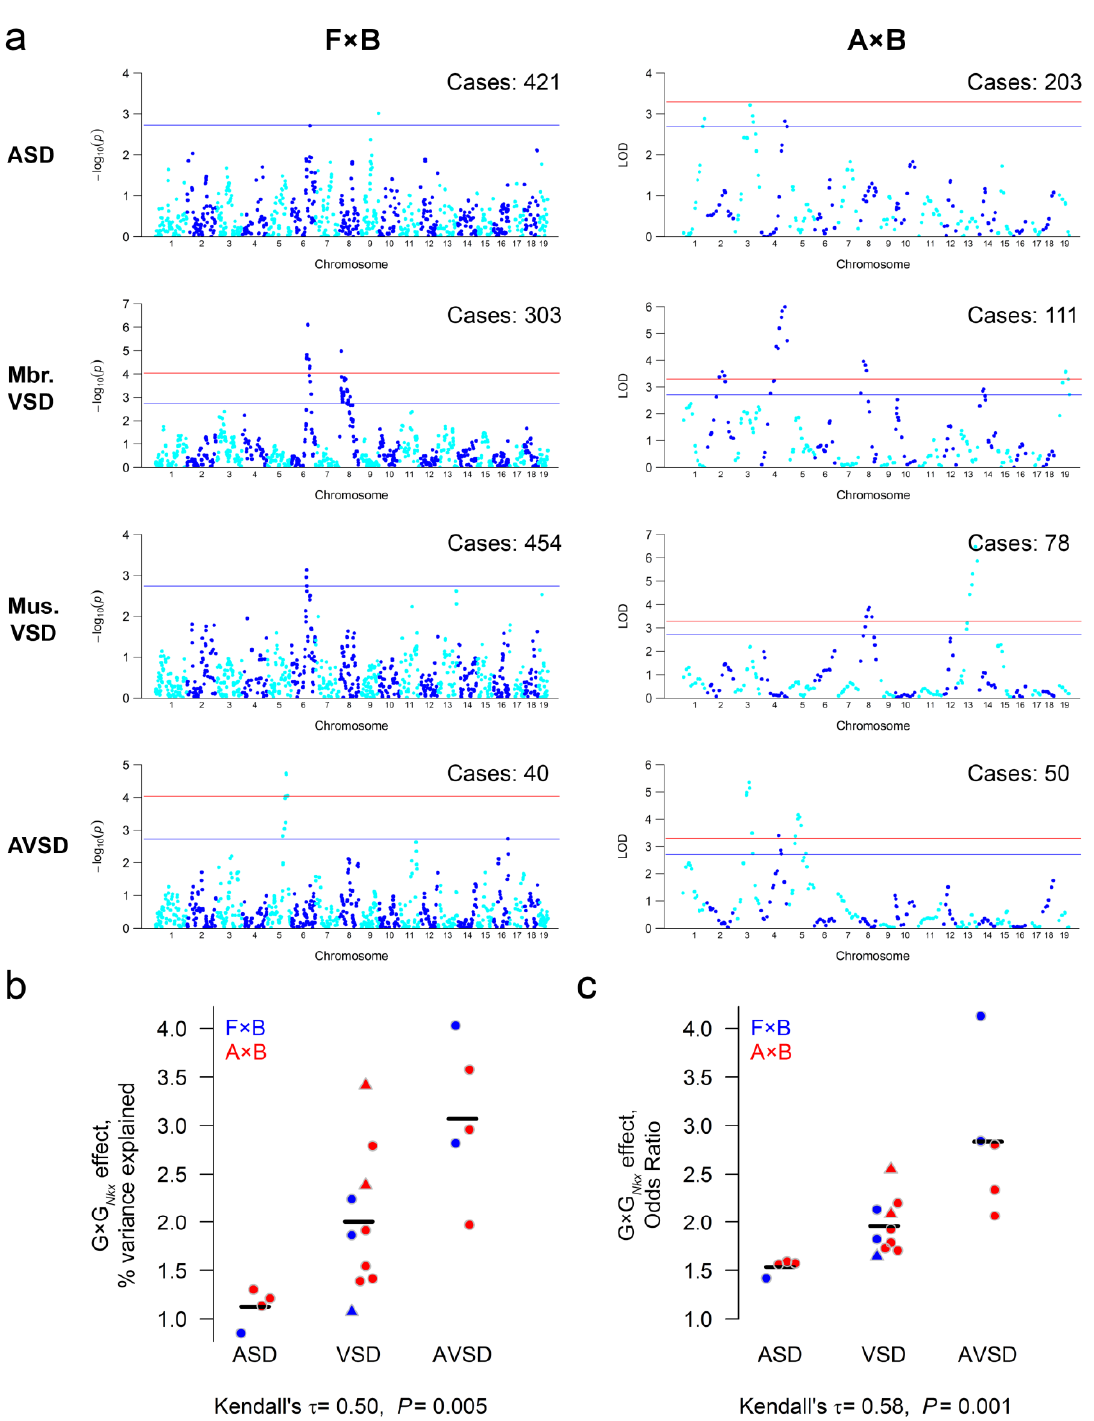
Figure 2. The quantitative effect of G × G Nkx interactions on risk correlates with the severity of a heart defect. ( a ) Genetic loci modify the risk of specific heart defects in Nkx2-5 +/ − mice from the F × B and A × B intercrosses. The number of affected Nkx2-5 +/ − newborns genotyped for each defect is indicated. Normal Nkx2-5 +/ − littermates were genotyped as controls ( N = 330 A × B and 1024 F × B). Suggestive and genome-wide significance thresholds are indicated in blue and red. ( b , c ) G × G Nkx effects on risk, quantified as the percent variance explained by the most significant SNP at a locus or the odds ratio for each risk allele, correlate with defect severity. Muscular (triangle) and membranous (circle) VSD loci are analyzed together because the two VSD types have similar severity. The hatch marks indicate the